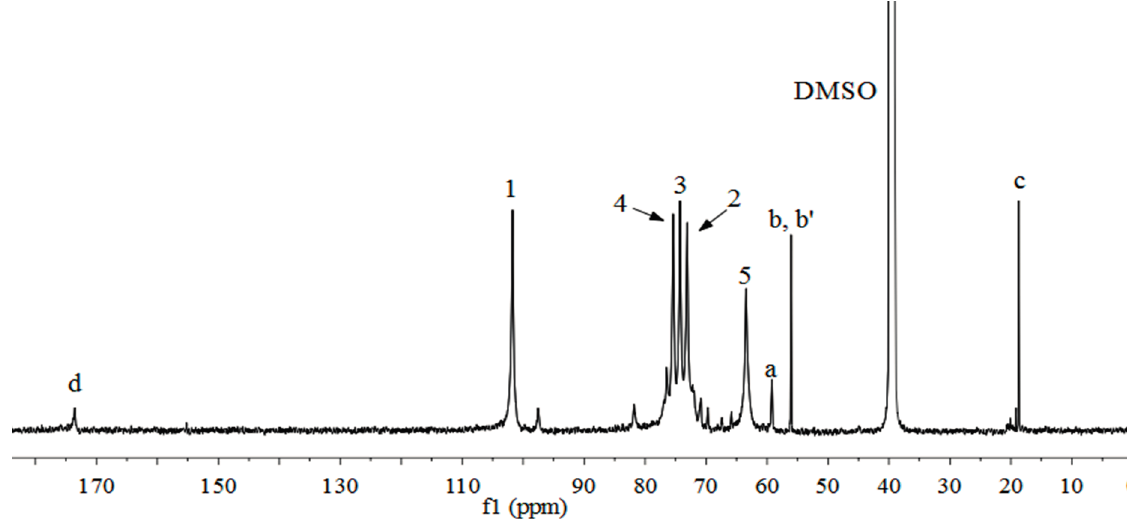
Figure 3. 13 C-NMR spectrum of xylan- g -PPC copolymer sample 12 (DS =